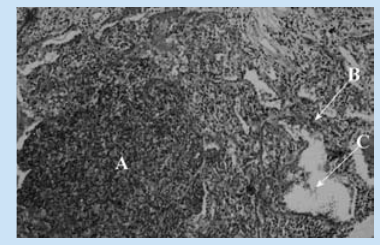
Fig. 1. Alymphoplasmacytic cellular infiltrate is present in the interstitium forming nodules (A) and expanding the alveolar walls (B). Alveolar spaces (C) are